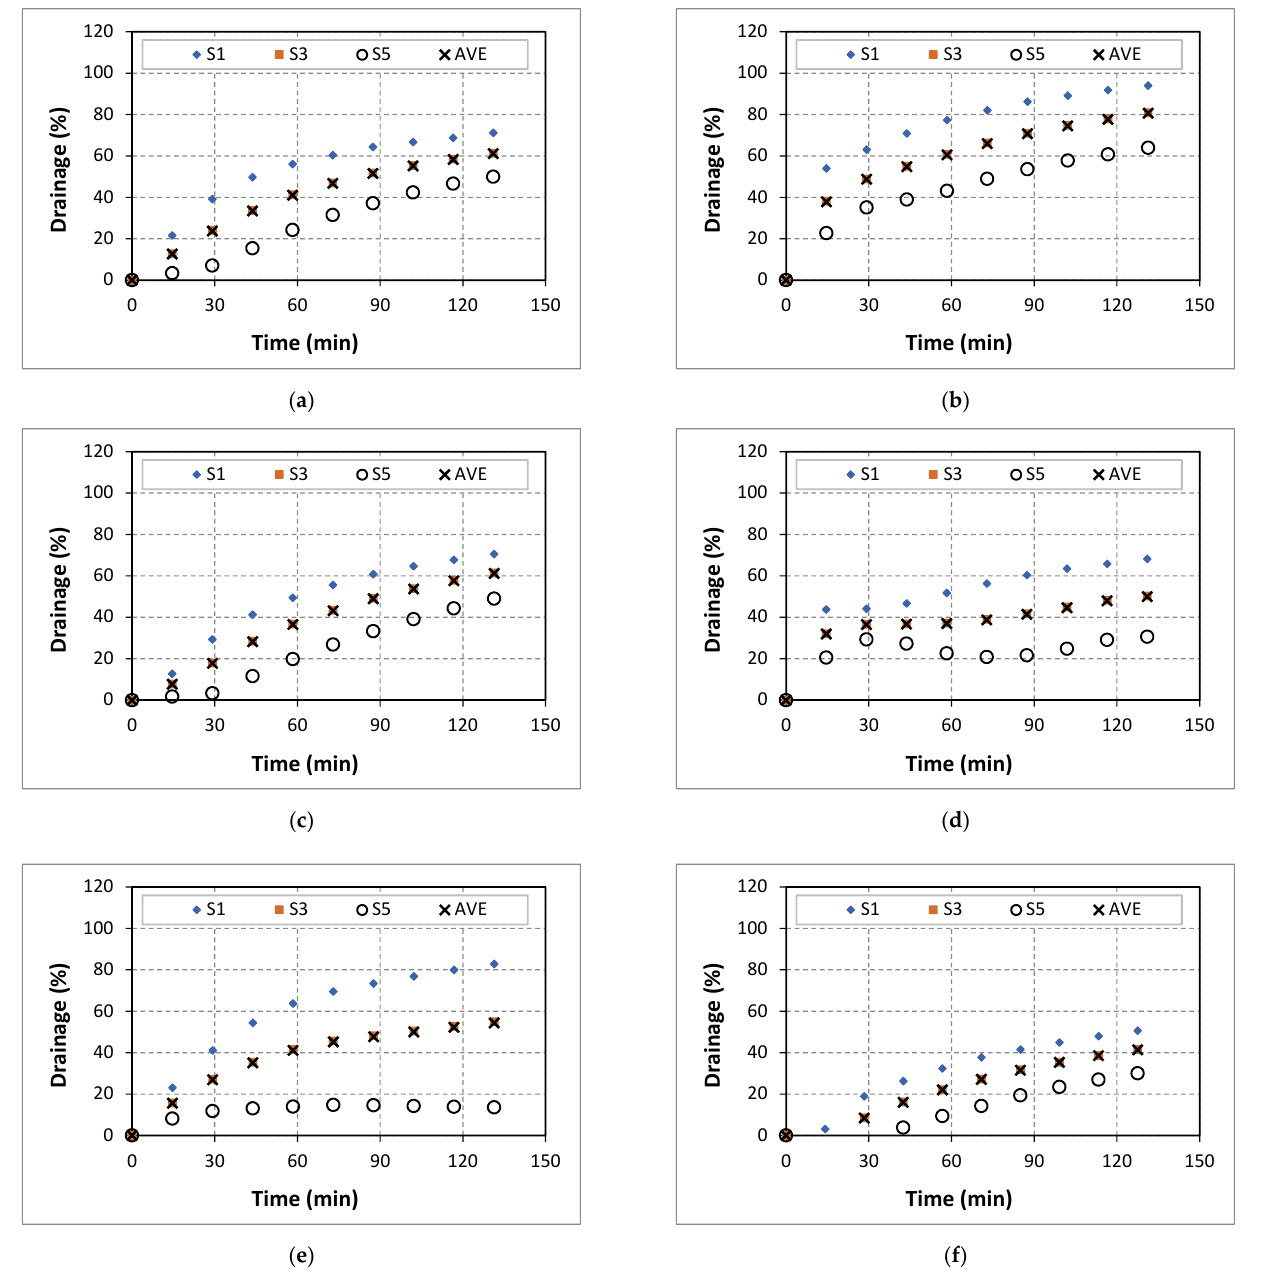
Figure 7. Drainage of 40% quality aqueous foam at different NaCl concentrations: ( a ) 0% wt., ( b ) 5% wt., ( c ) 7% wt., ( d ) 9% wt., ( e ) 14% wt., and ( f ) 18% wt.